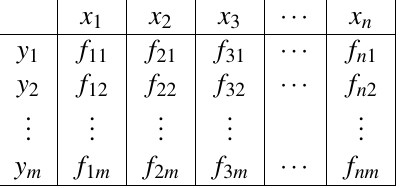
Table 1 Radiation dosage at the grid